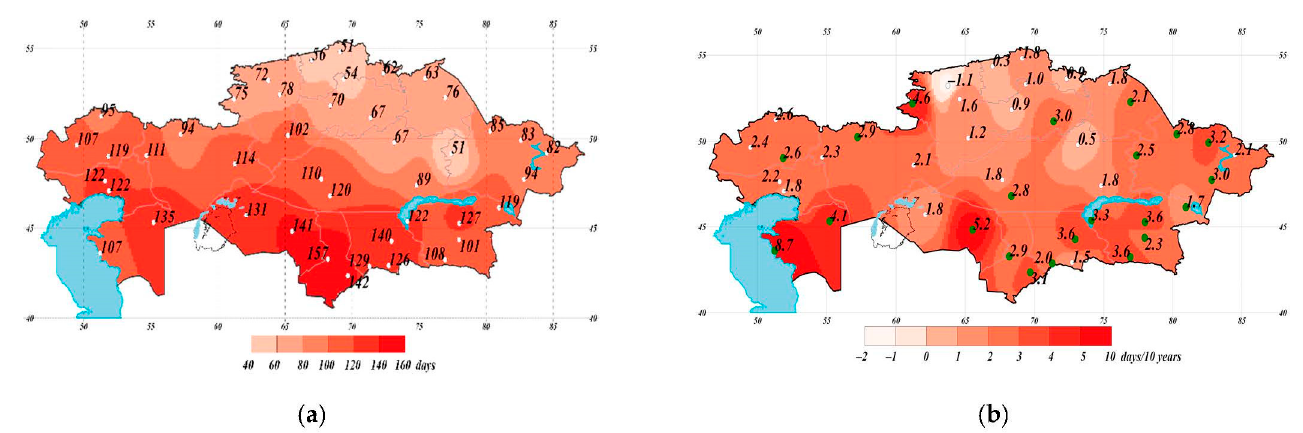
Figure 4. Spatial distribution of the index characterizing the number of days with maximum daily temperature < 25 °C (SU) ( a ) and trends ( b ) of this parameter for the period 1971–2020. Changes in SU over time tend to rise across the board. At the same time, the observed trends are statistically significant. The most significant positive trends are observed in the territory of southern Kazakhstan, as well as in the south of western Kazakhstan, and range from 3 to 9 days in 10 years.